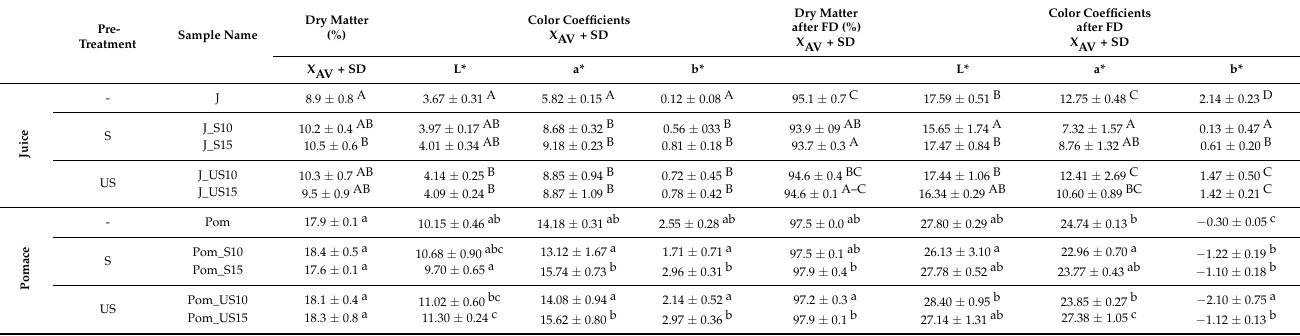
Table 1. Physical properties of beetroot juice and pomace before and after